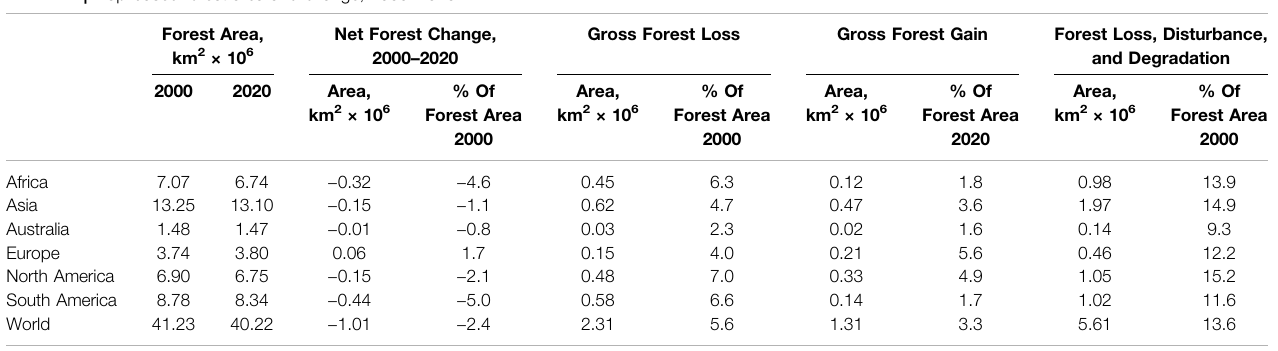
TABLE 1 | Map-based forest area and change, 2000 –